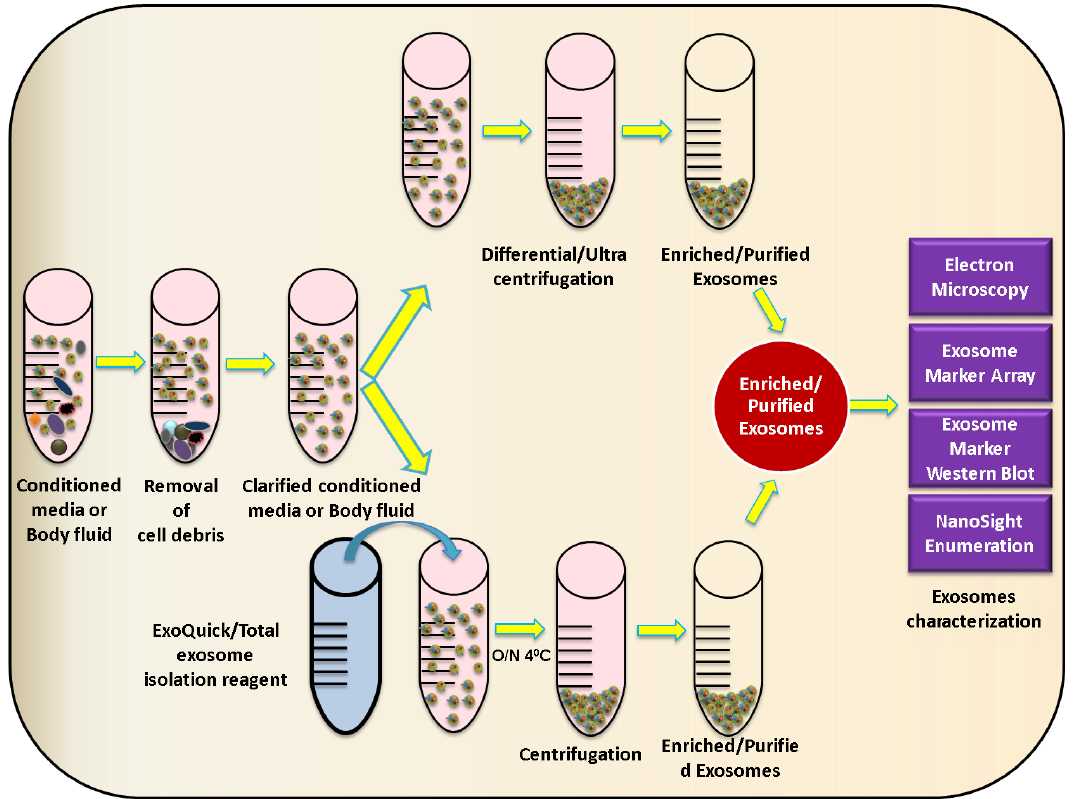
Figure 3. Schematic representation of exosome isolation strategies. Graphical representation of exosome isolation by both ultracentrifugation- and precipitation reagent-based isolation procedures, and analytical tools for exosome